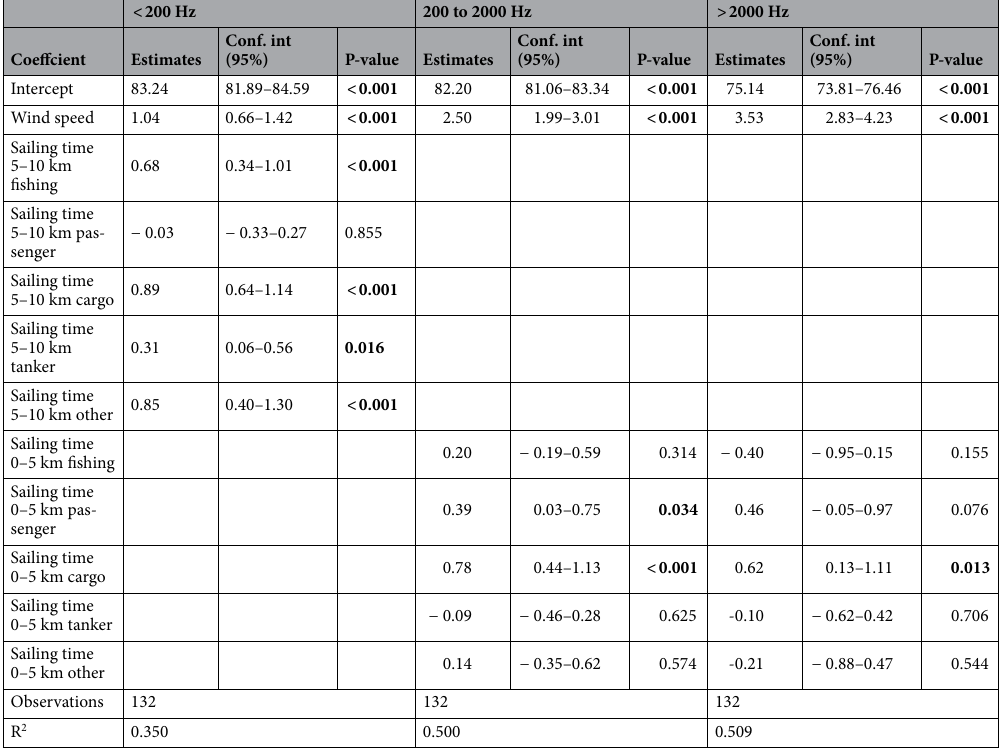
Table 2. Statistical model results for the three models selected. Significant values are in